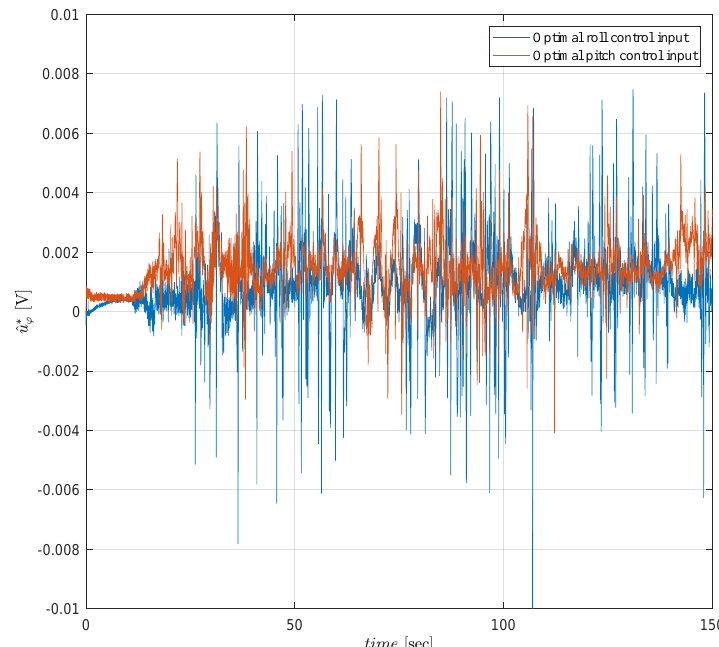
Figure 12. Optimal attitude control inputs for the complementary